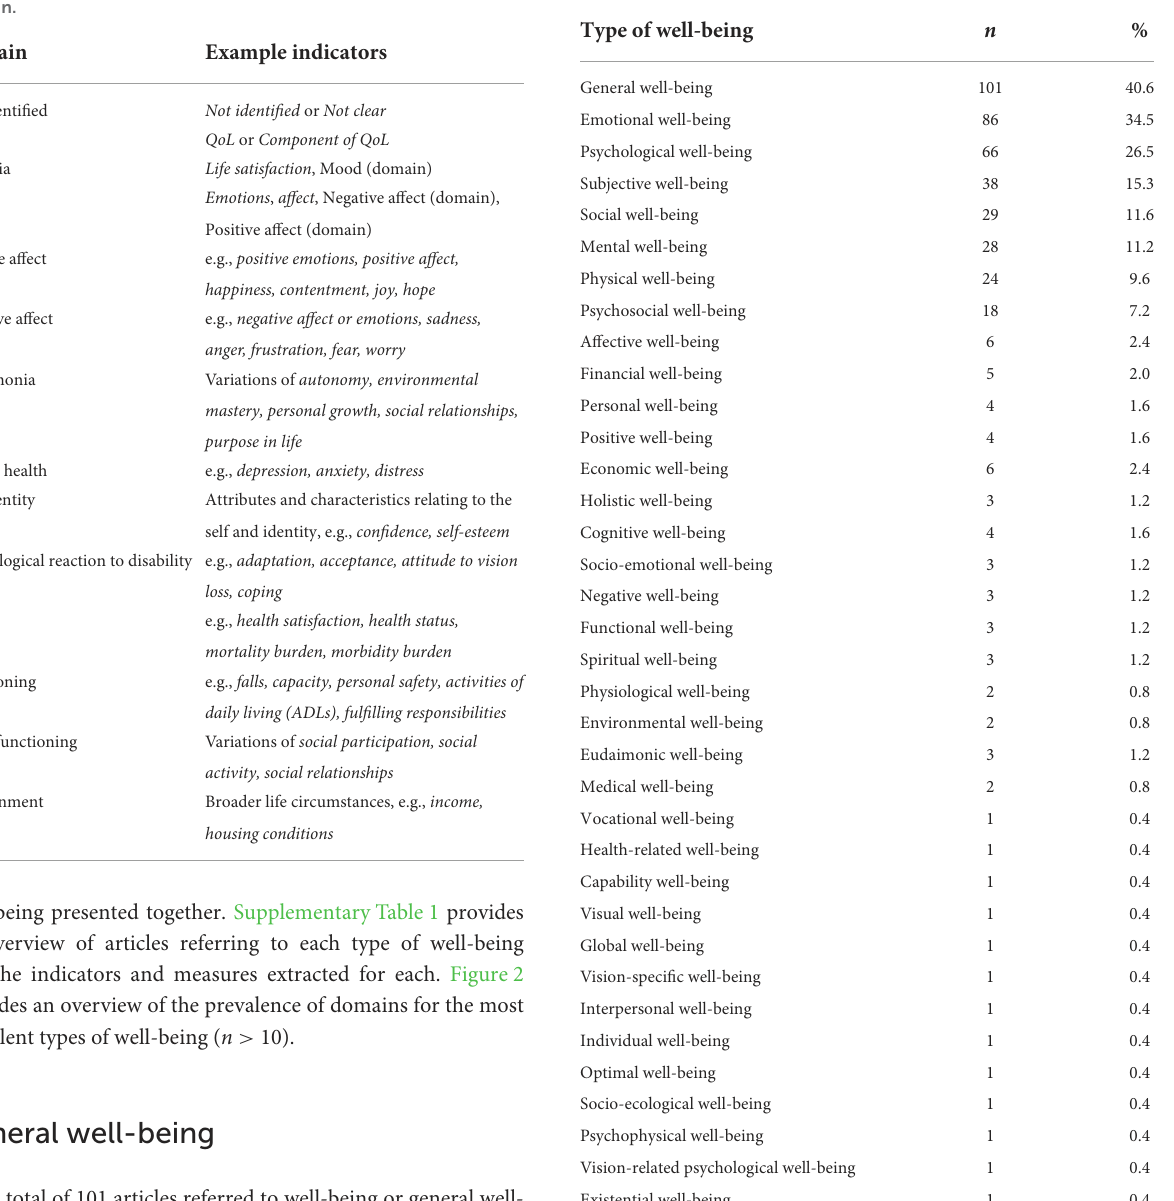
TABLE 2 Frequency and prevalence of types of